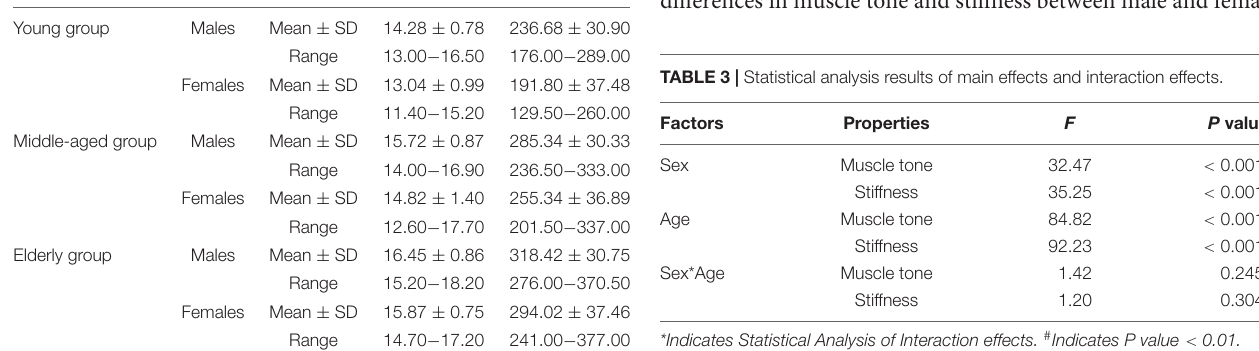
*Indicates Statistical Analysis of Interaction effects. # Indicates P value <